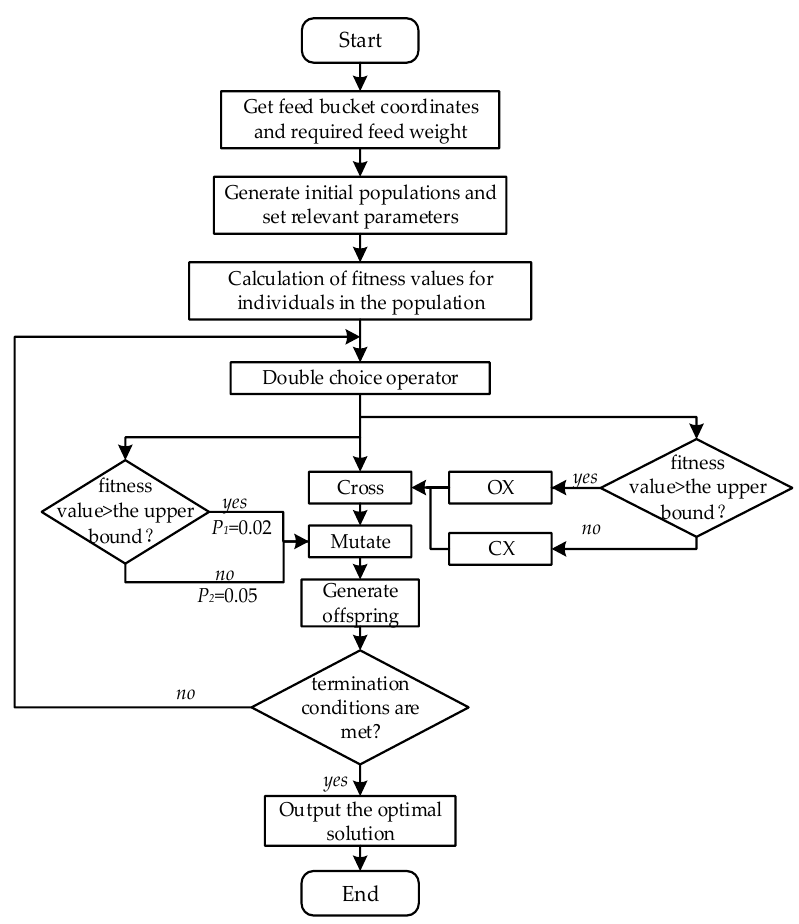
Figure 11. Large-scale feeding point path planning calculation process.